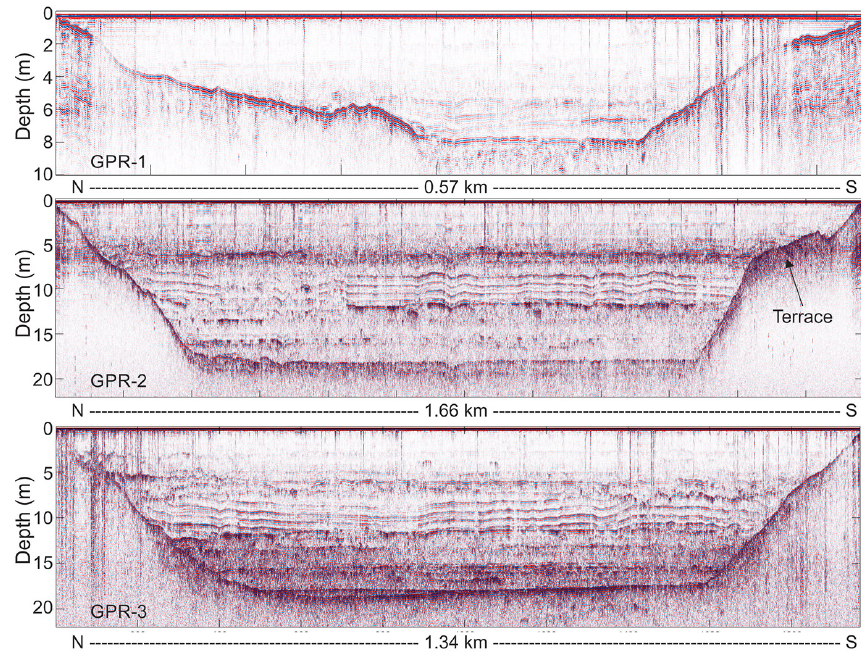
Figure 7. GPR profiles recorded north to south across Lake Vida (Fig. 1).